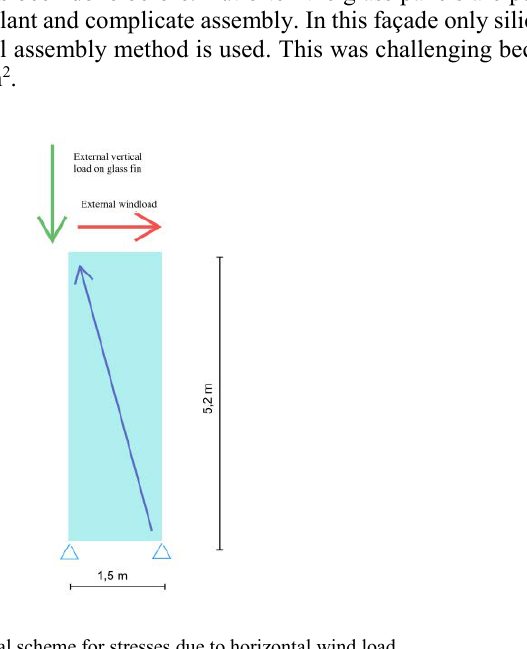
Fig. 5 mechanical scheme for stresses due to horizontal wind load.